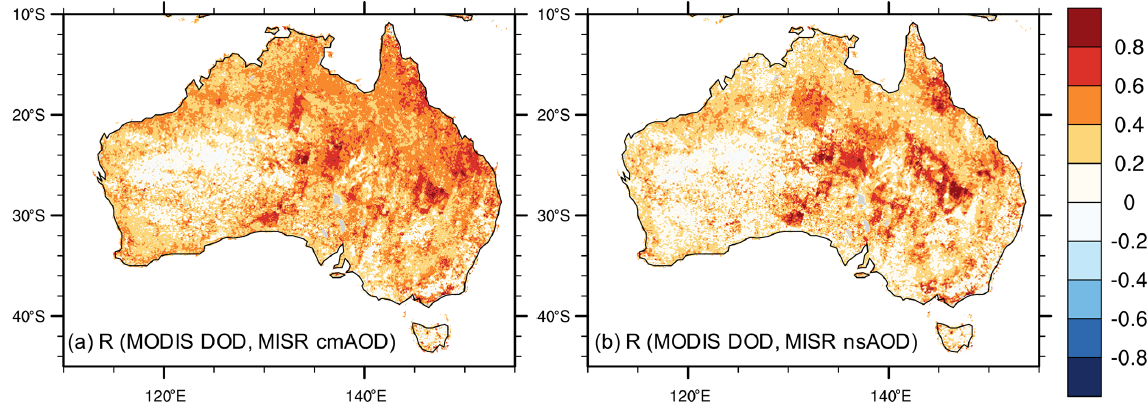
Figure 7. Correlation between colocated, daily MODIS-Terra DOD and MISR (a) cmAOD and (b) nsAOD. The number of collocations per pixel between MODIS and MISR during 2000–2019 generally varies from 100 to 800 for DOD and 20 to 200 for nsAOD. Grey indicates areas with fewer than 10 collocations per